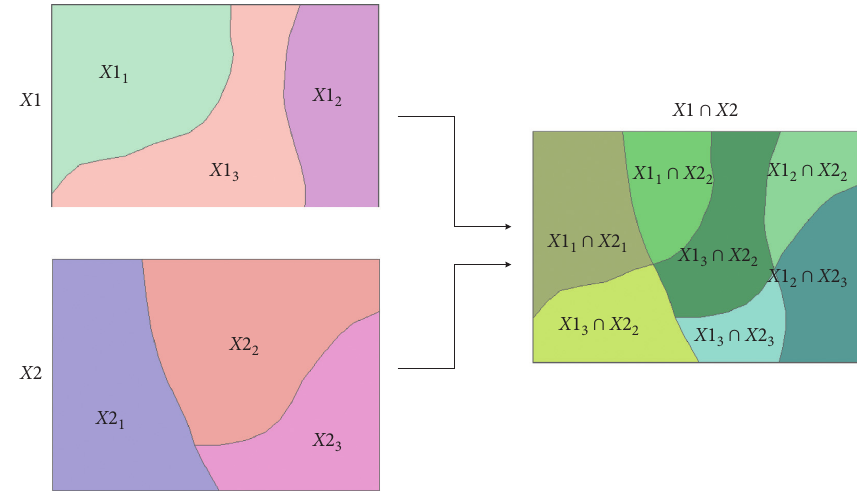
Figure 2: Detection of interactions. Table 3: Types of interactions between two factors [33].